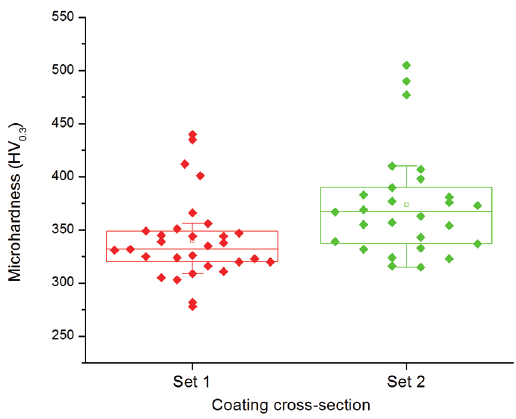
Figure 7: Indication of outliers in the cross-section microhardness of CWHS samples